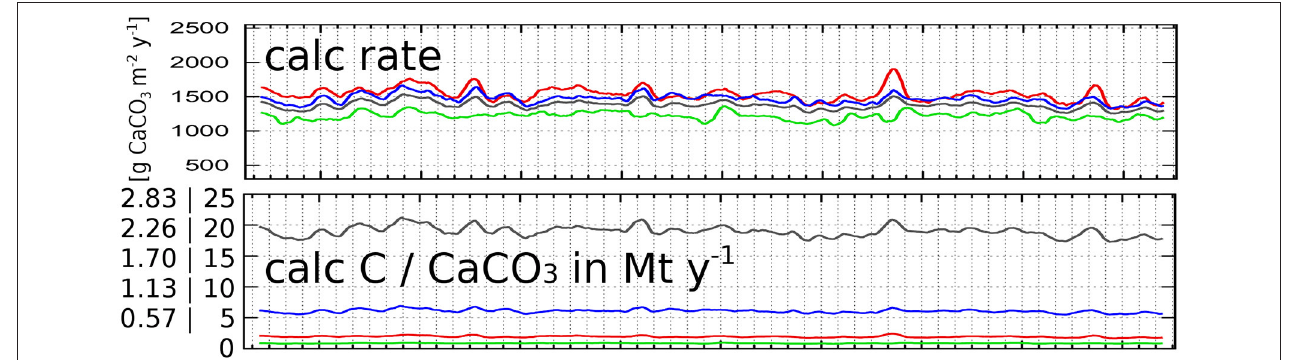
FIGURE 10 | Simulated aragonite calcification rates as spatially averaged yearly running means for the entire Sunda Shelf Sea (gray), Gulf of Thailand (red), Malacca Strait (green), and the Java Sea (blue). Shown are the rates in gCaCO 3 m − 2 y − 1 (upper), and in Mty − 1 of carbon and of aragonite.